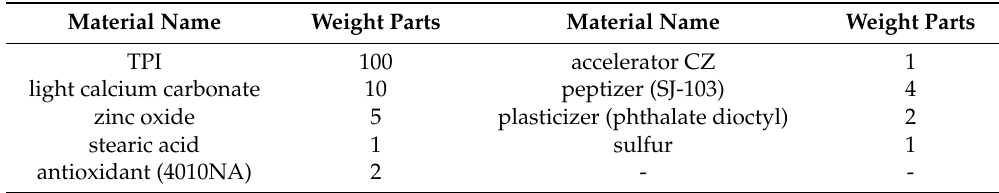
Table 1. The main raw materials